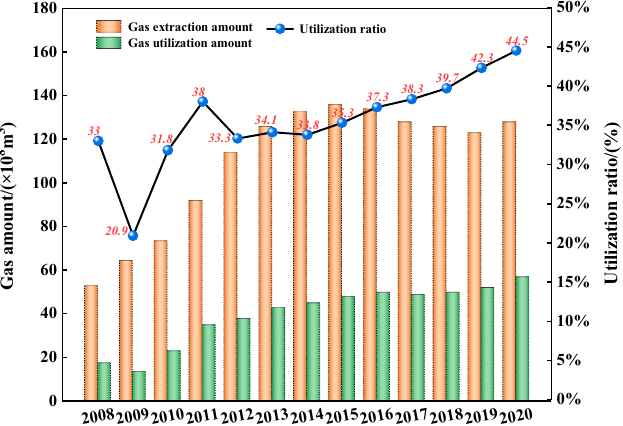
Figure 2. Underground coal mine methane extraction, utilization and utilization ratio in China.